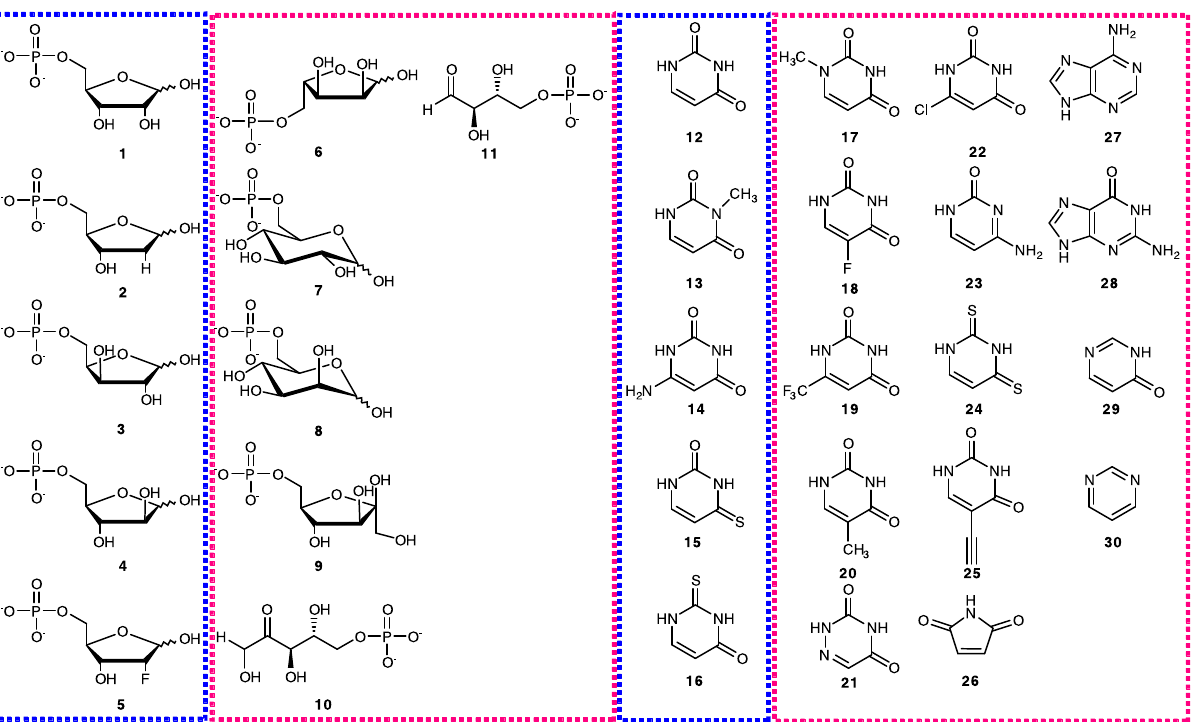
Fig. 2 Substrate scope of YeiN. Substrates tested for C -glycosylation by YeiN. The compounds framed in blue are active while those framed in magenta are not.